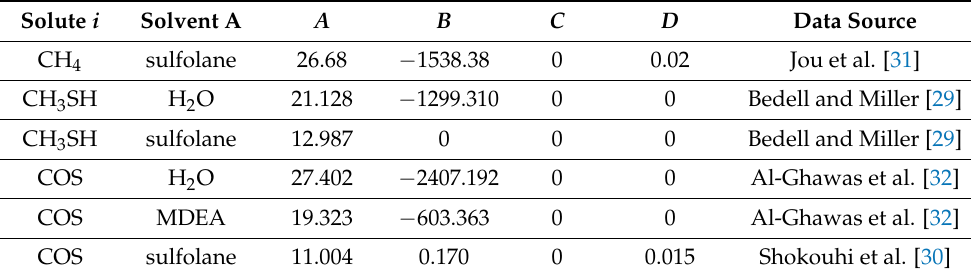
Table 1. Parameters for Henry’s